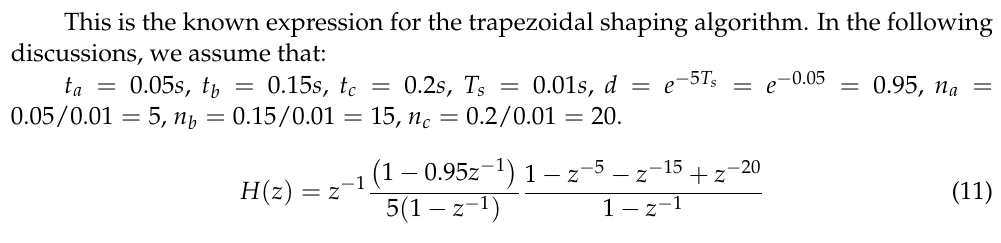
Figure 4. Trapezoidal pulse synthesis.